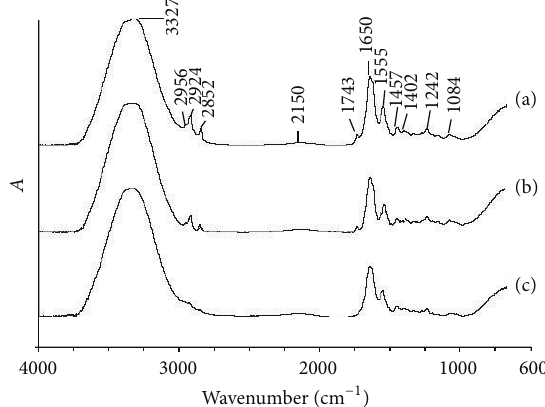
Figure 2: FT-IR spectra of pancreatic tissue samples. (a) Normal tissues; (b) early carcinoma tissues; (c) advanced carcinoma